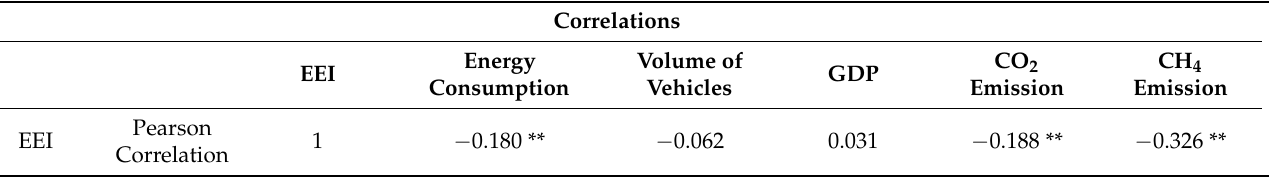
Table 7. Correlation between the EEI and inputs/outputs with all data during 2005–2019. Source: authors’ estimation.